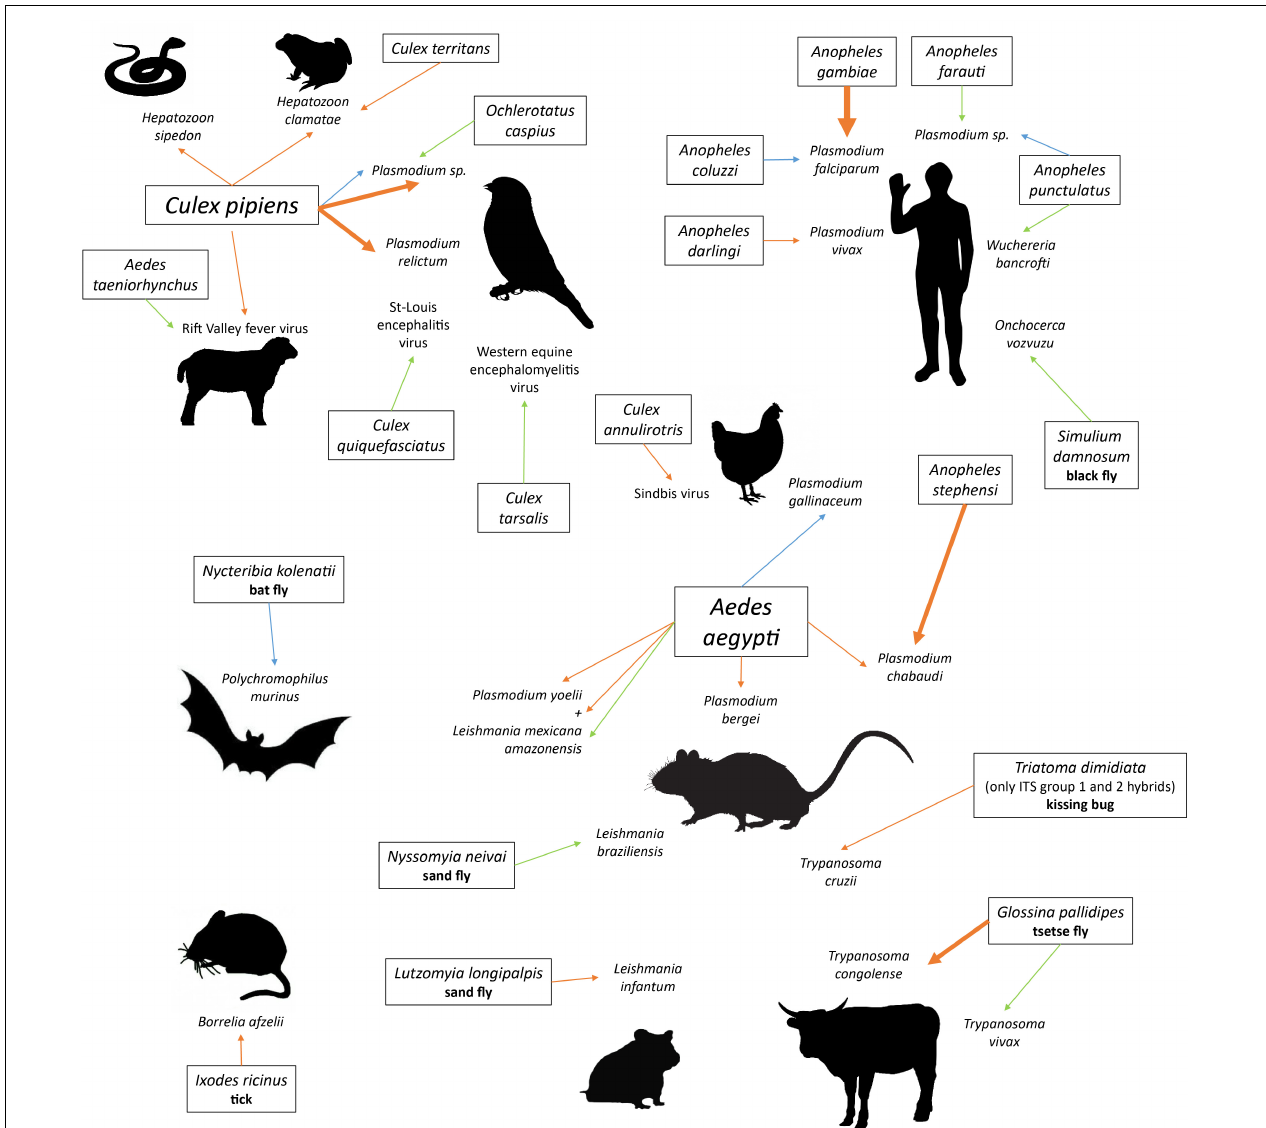
FIGURE 1 | Pairs of vector-parasite species that have been tested for differential attractiveness of infected versus uninfected hosts. Line width is proportional to the number of studies finding this result. Orange lines: higher attractiveness of infected hosts; blue lines: higher attractiveness of uninfected hosts; green lines: no preference found. Species names in boxes are vectors; latin names that are not followed by a vernacular name are mosquitoes